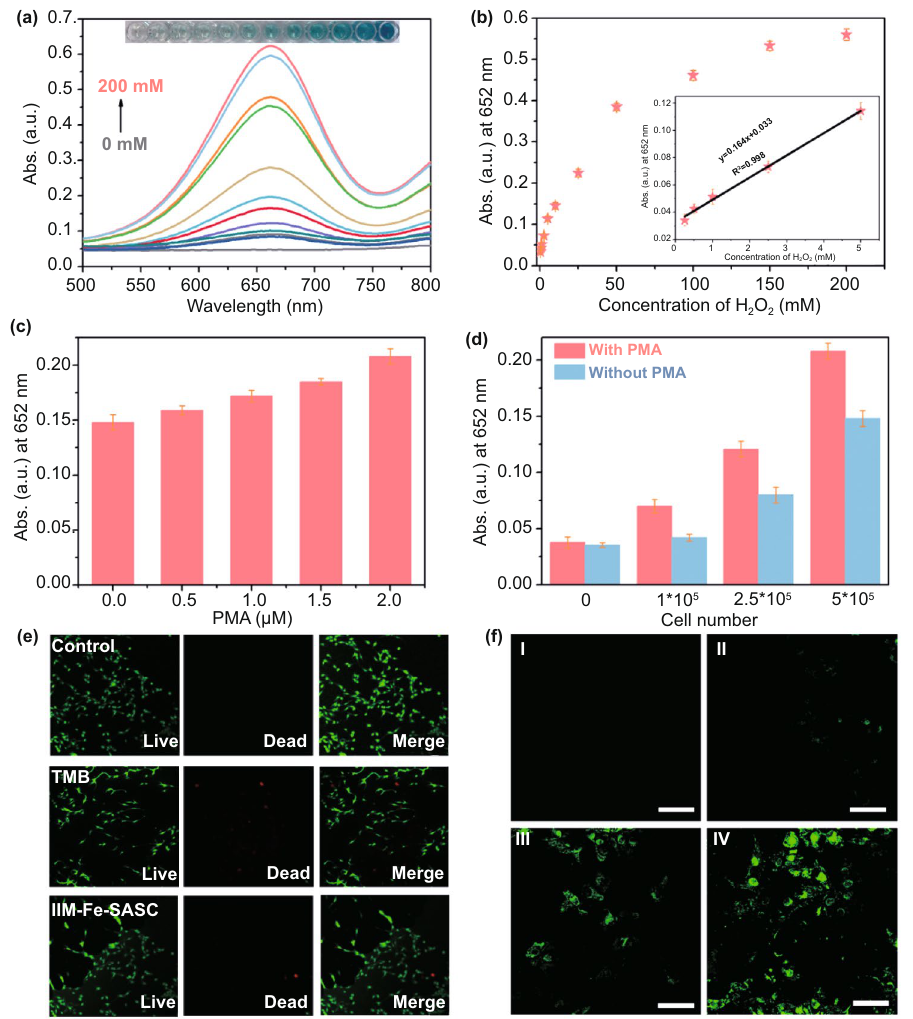
Fig. 5 a UV–vis spectra of TMB oxidized by the IIM-Fe-SASC under different H 2 O 2 concentrations. b Absorbance changes and linear calibra- tion plot (inset) for H 2 O 2 detection. c Absorbance values of H 2 O 2 generated from MDA-MB-231 cells after treating with various concentrations of PMA. d Absorbance comparison toward MDA and PMA-treated MDA-MB-231 cells. e Fluorescence imaging of MDA-MB-231 cancer cells cultured with TMB and IIM-Fe-SASC nanoprobe. f CLSM images of active intermediates generated in MDA-MB-231 cells treated with differ- ent amount of IIM-Fe-SASC nanoprobe (I: 0 μg mL −1 ; II: 2.5 μg mL −1 ; III: 5 μg mL −1 ; IV: 10 μg mL −1 ). The intracellular ROS generation was detected by the DCFH-DA (Scale bar: 60